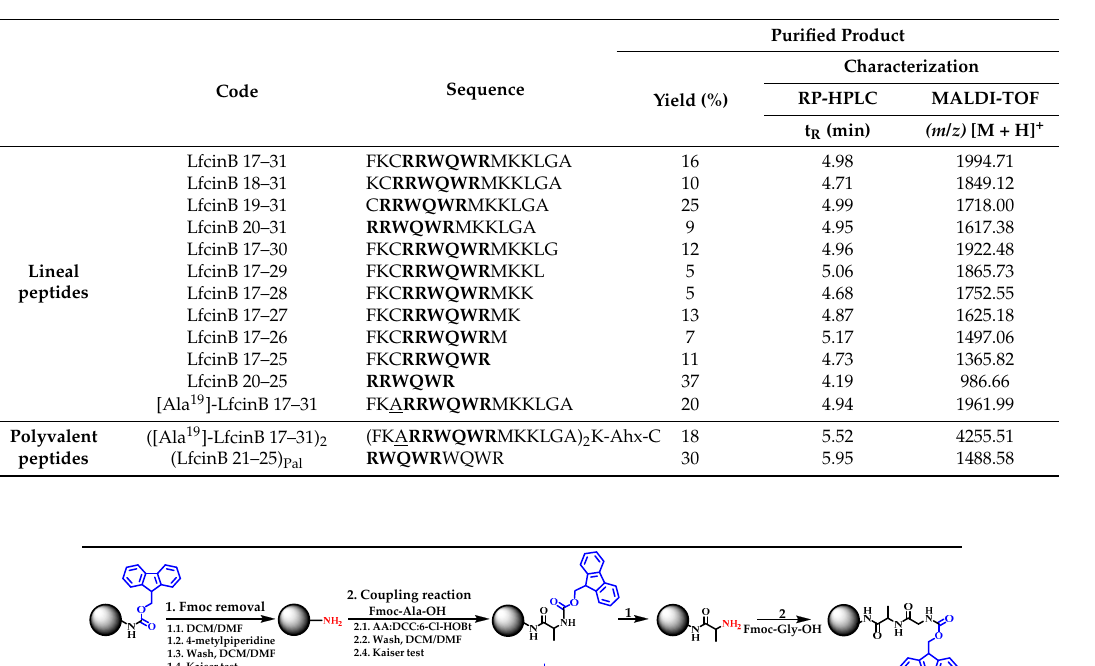
Table 1. Designed peptides derived from LfcinB 17–31.